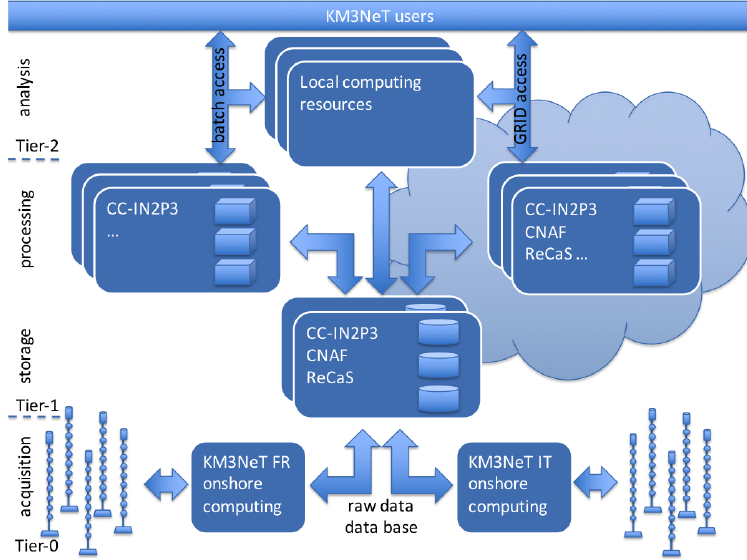
Figure 1. KM3NeT computing model scheme illustrating the data